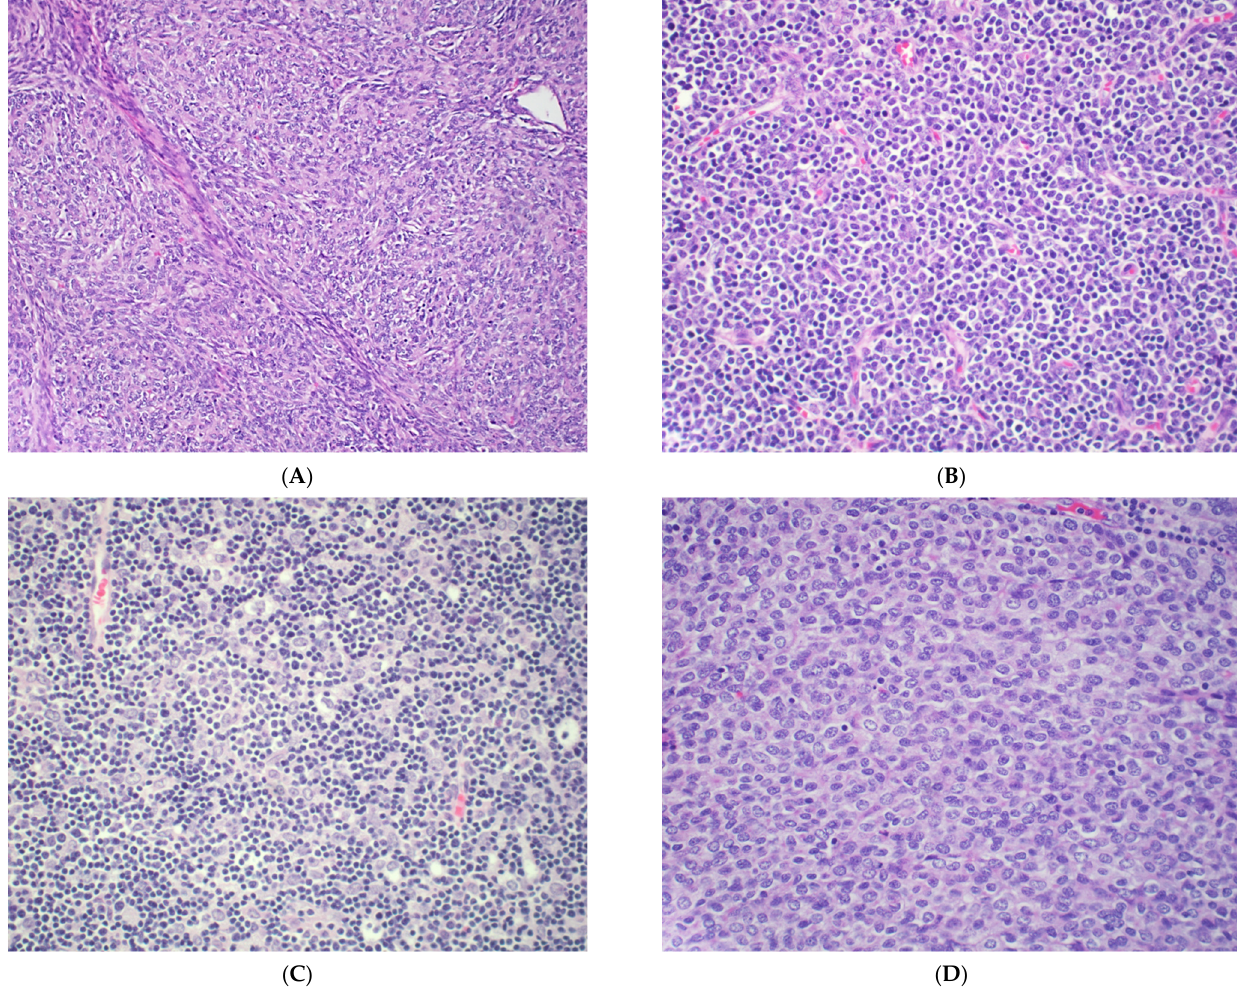
Figure 1. Histological subtypes of thymoma. ( A ) Type A thymoma with spindle epithelial cells. ( B ) Type B1 thymoma with rare epithelial cells and abundant lymphocytes. ( C ) Type B2 thymoma with epithelial islands admixed with lymphocytes. ( D ) Type B3 thymoma with round to ovoid epithelial cells and rare lymphocytes. All images show H&E stains, 20 × objective. Thymic epithelial cells express squamous markers (p40, p63, and cytokeratins) and markers of thymic origin (PAX8, FOXN1, and CD205) [1,18–20]. Thymic lymphocytes show reactivity for TdT, CD99, CD5, and CD3, which may be detected via flow cytometry [1]. CD5 is commonly expressed in the epithelial cells of thymic carcinomas, while in